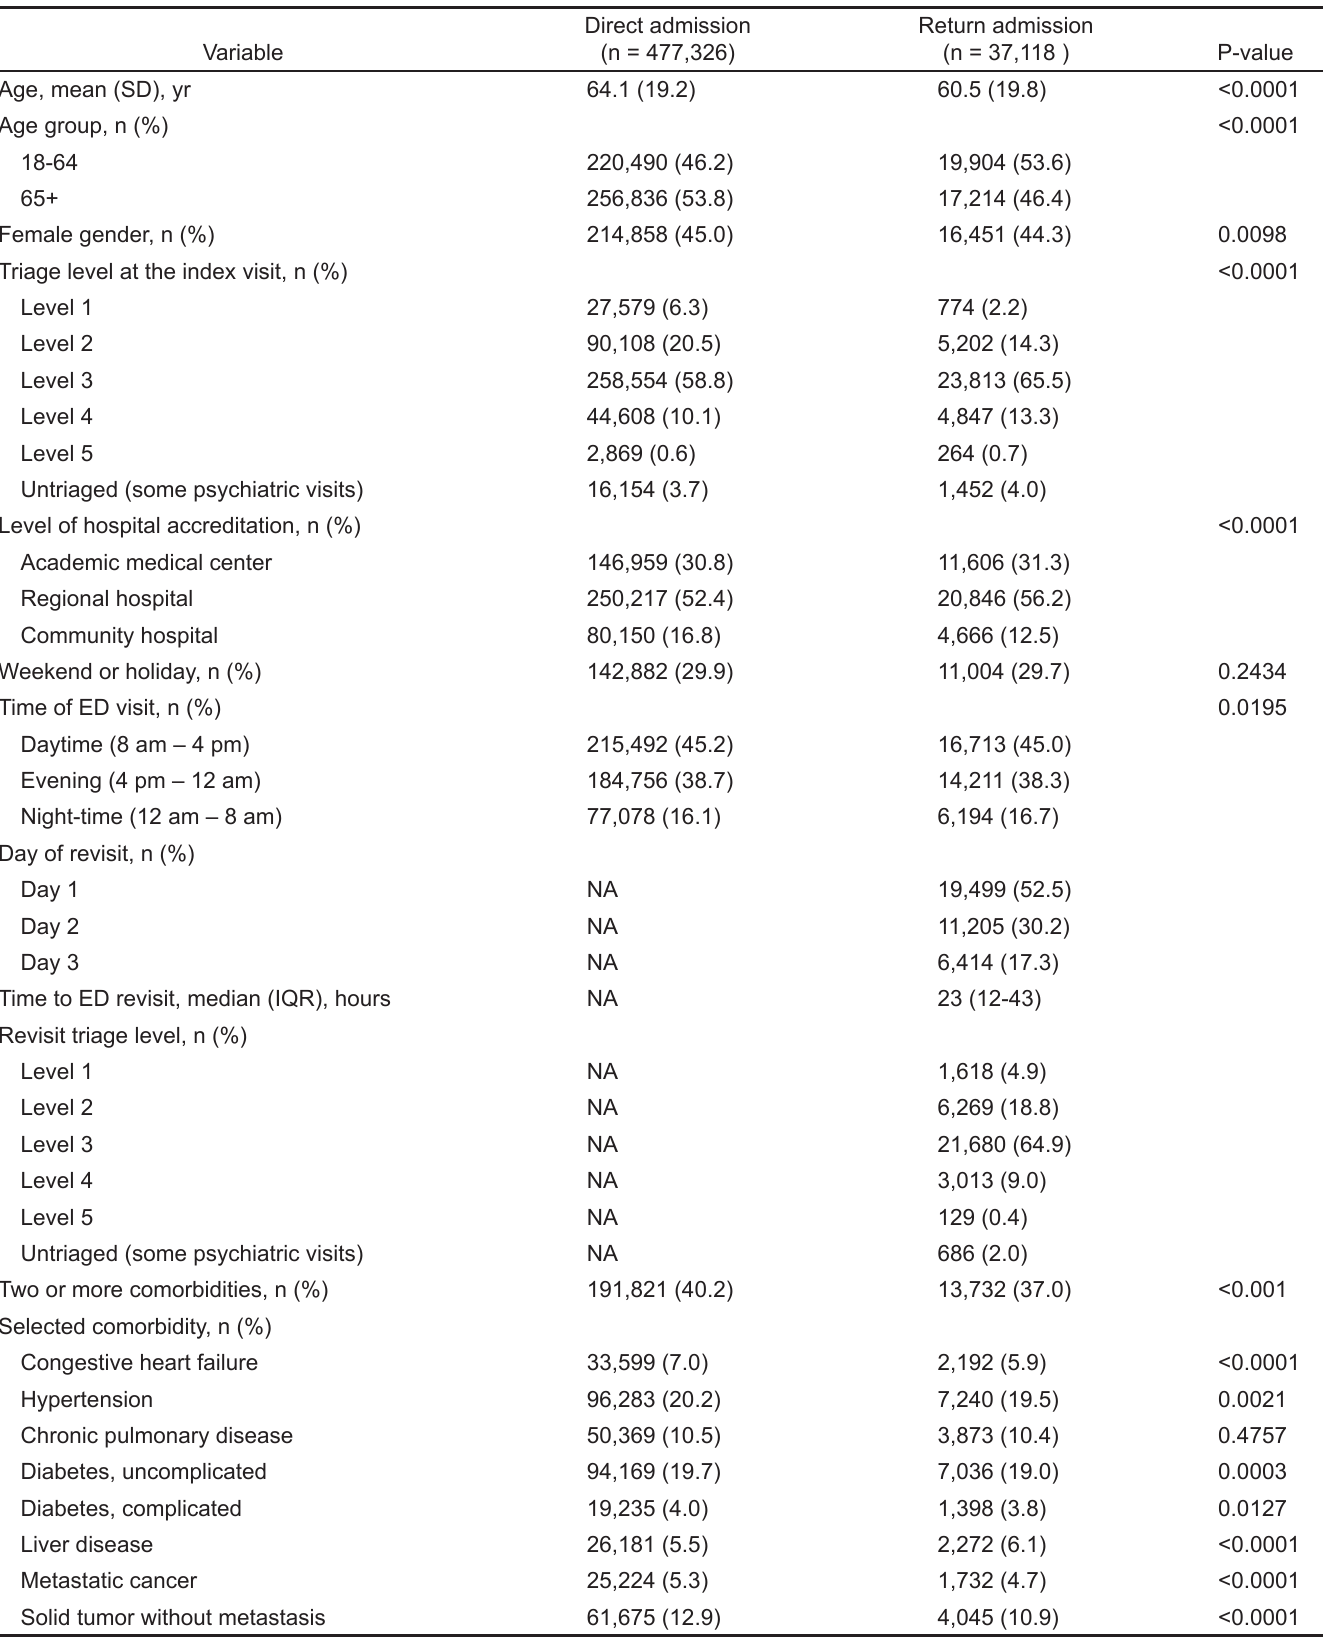
Table 1. Characteristics of hospitalizations stratified by revisit